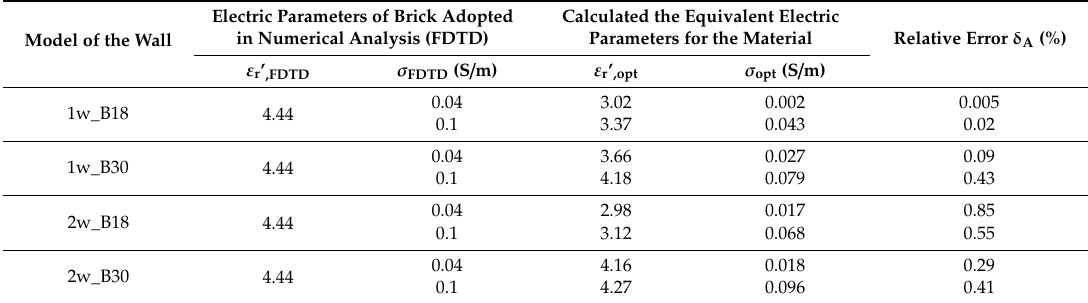
Table 5. Identified e ff ective electric parameters for 1 w and 2 w walls (B18 and B30) at f = 5 GHz. Electric Parameters of Brick Adopted Calculated the Equivalent Electric in Numerical Analysis (FDTD) Parameters for the Model of the Wall